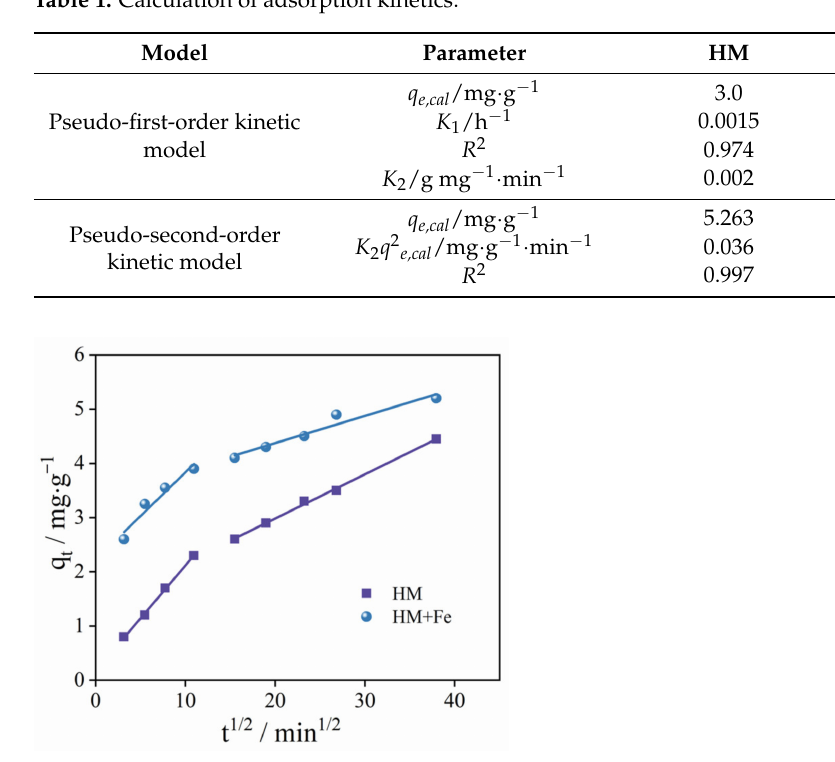
Figure 3. Weber–Morris intraparticle diffusion model of tetracycline on HM and HM+Fe. Table 2. Calculation of Weber–Morris